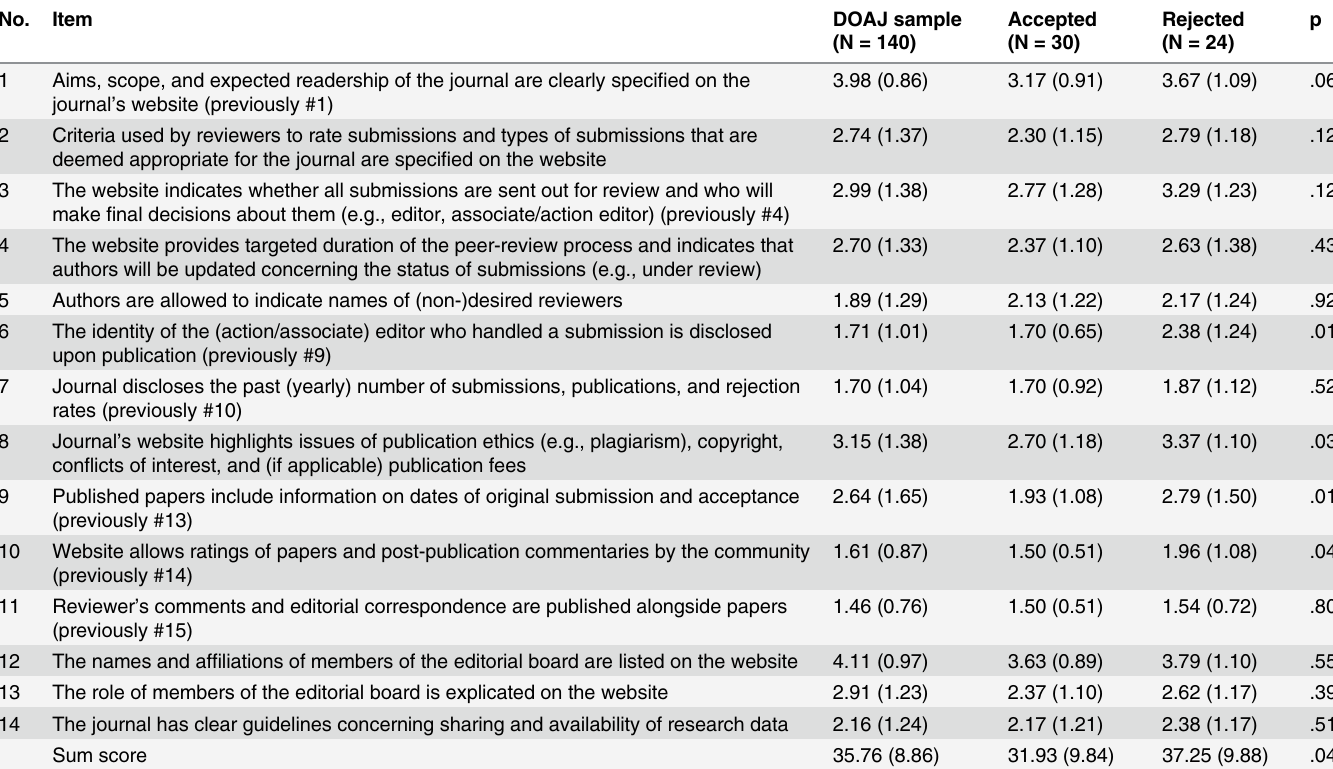
Table 6. Descriptive statistics of transparency ratings for DOAJ journals and journals that accepted or rejected the hoax paper (Study 3). No.